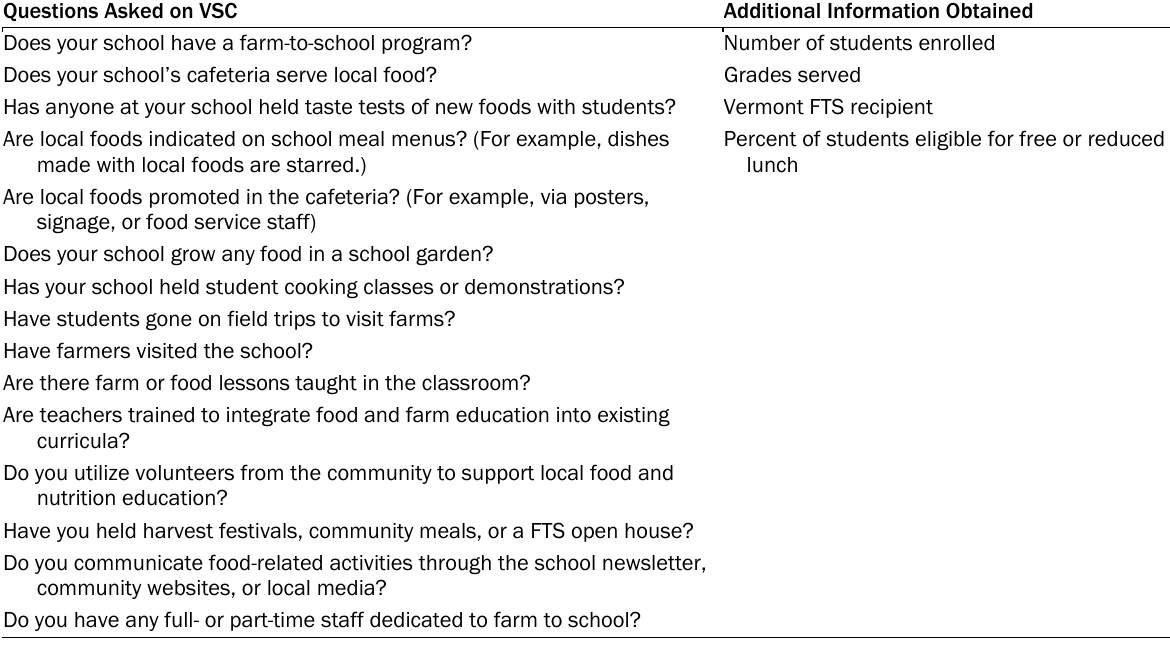
Table 1. VSC Questions and Additional Information about Vermont Public